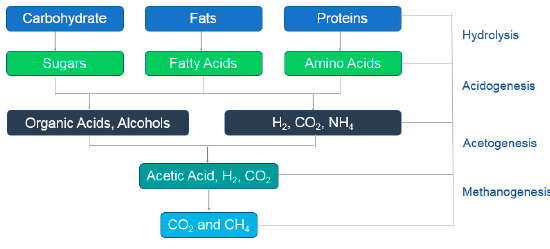
Figure 2. Anaerobic digestion reaction processes.